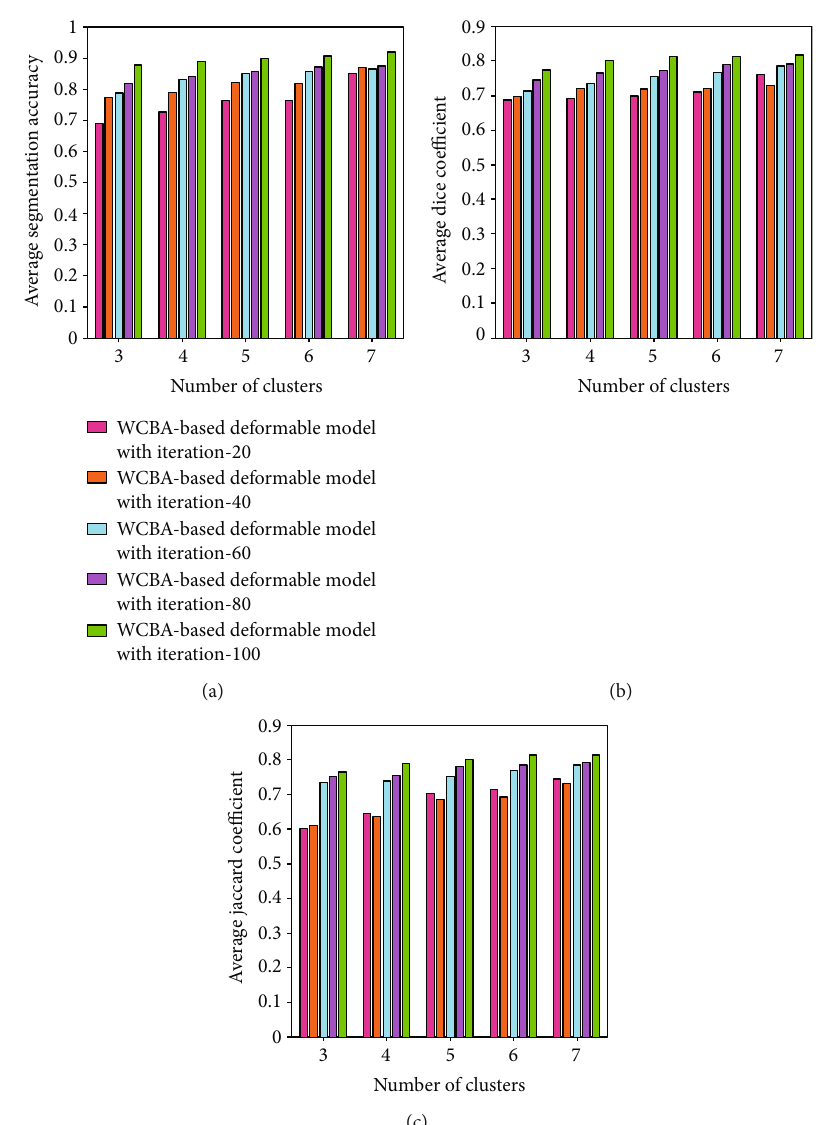
Figure 3: Performance evaluation of the proposed method for di ff erent values of iterations: (a) average segmentation accuracy, (b) average Dice coe ffi cient, and (c) average Jaccard coe ffi